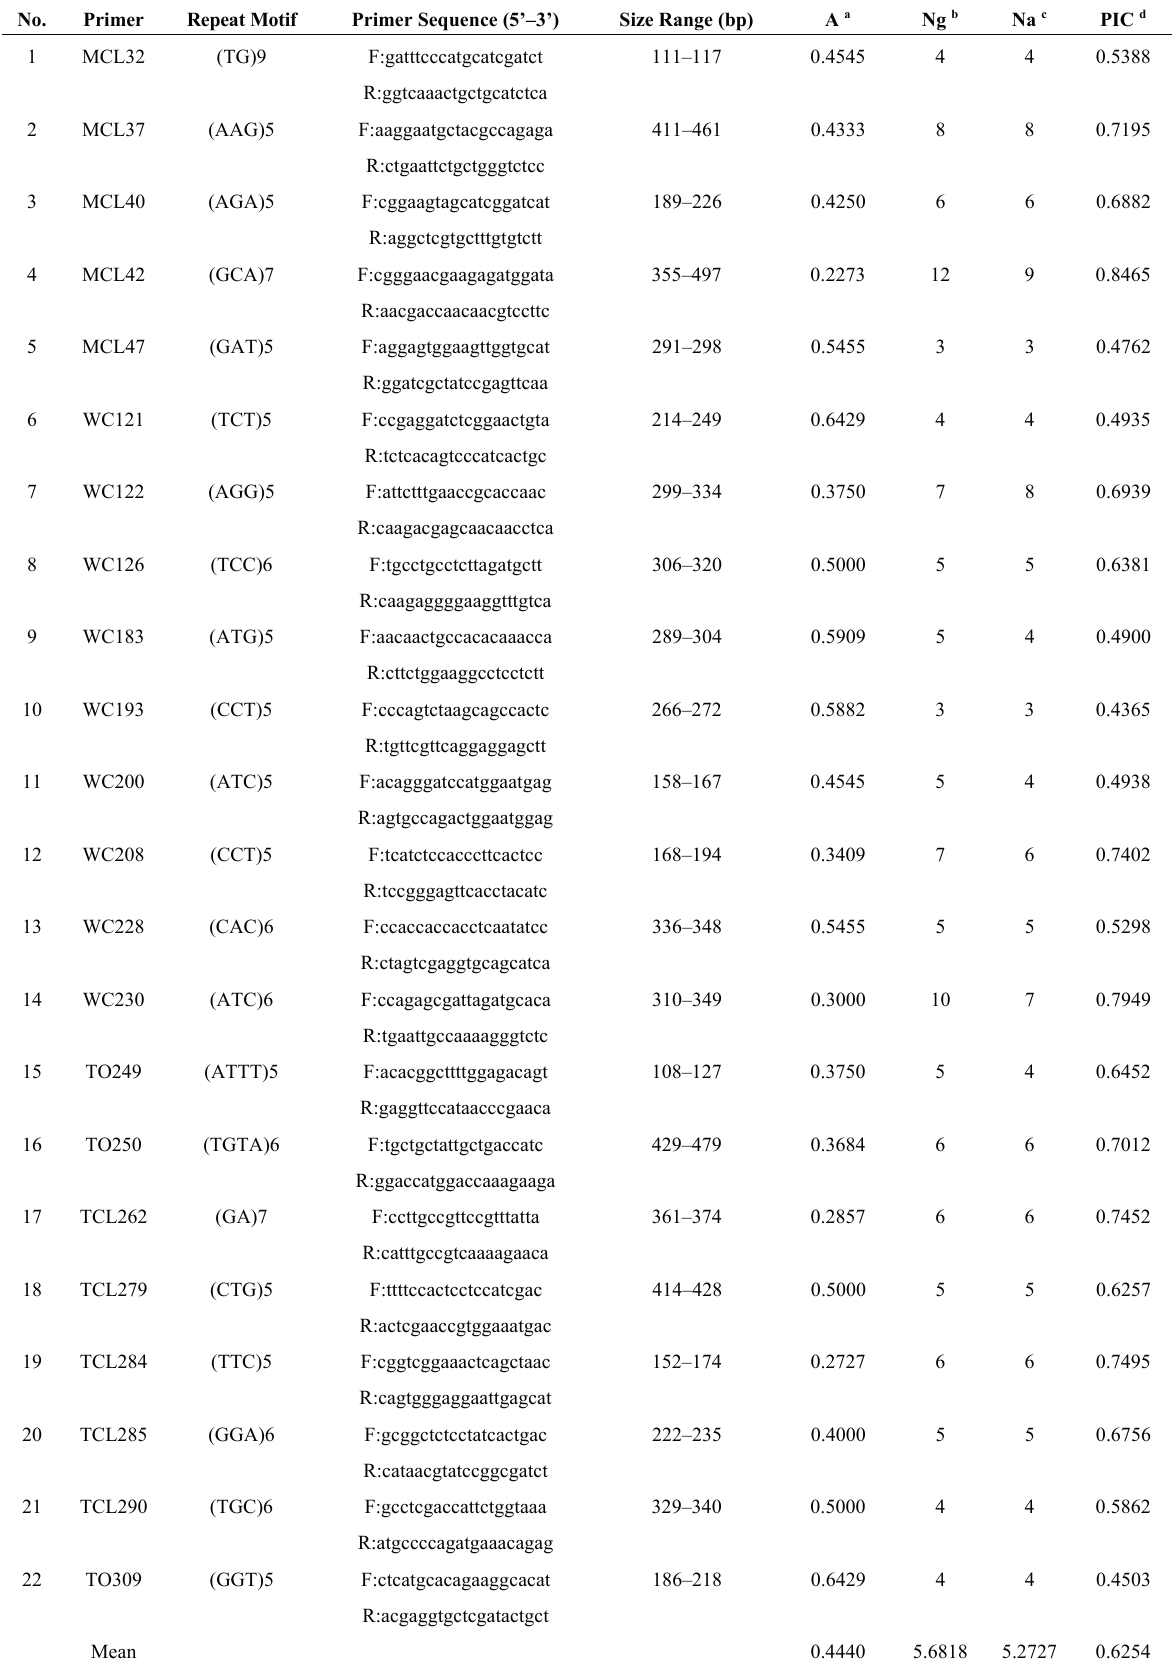
Table 4. Characteristics of the 22 polymorphic SSR markers validated in 22 Allium